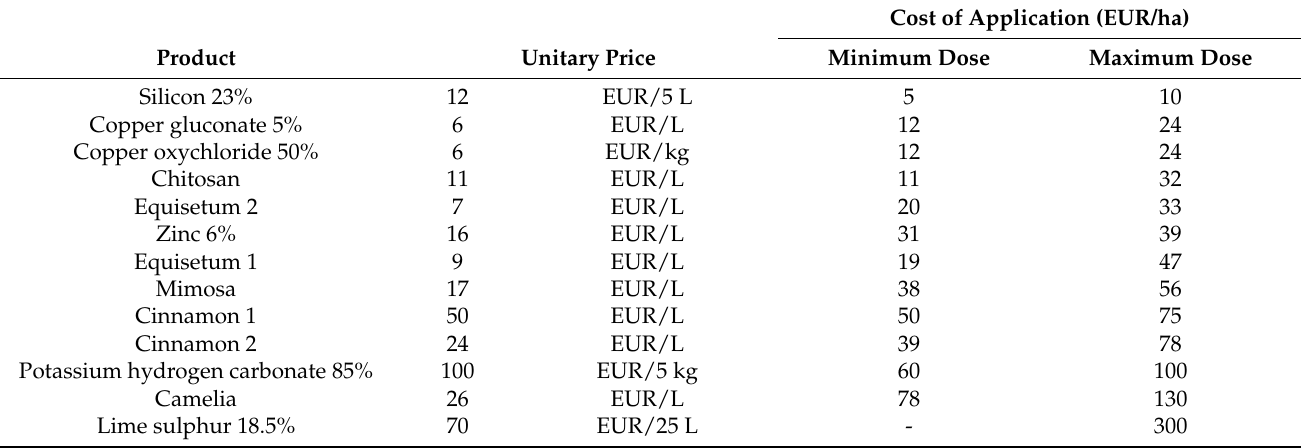
Table 2. Real costs per unit of treatment (ha) for the products evaluated. A volume application of 1000 L/ha has been assumed. Data are referenced for the year